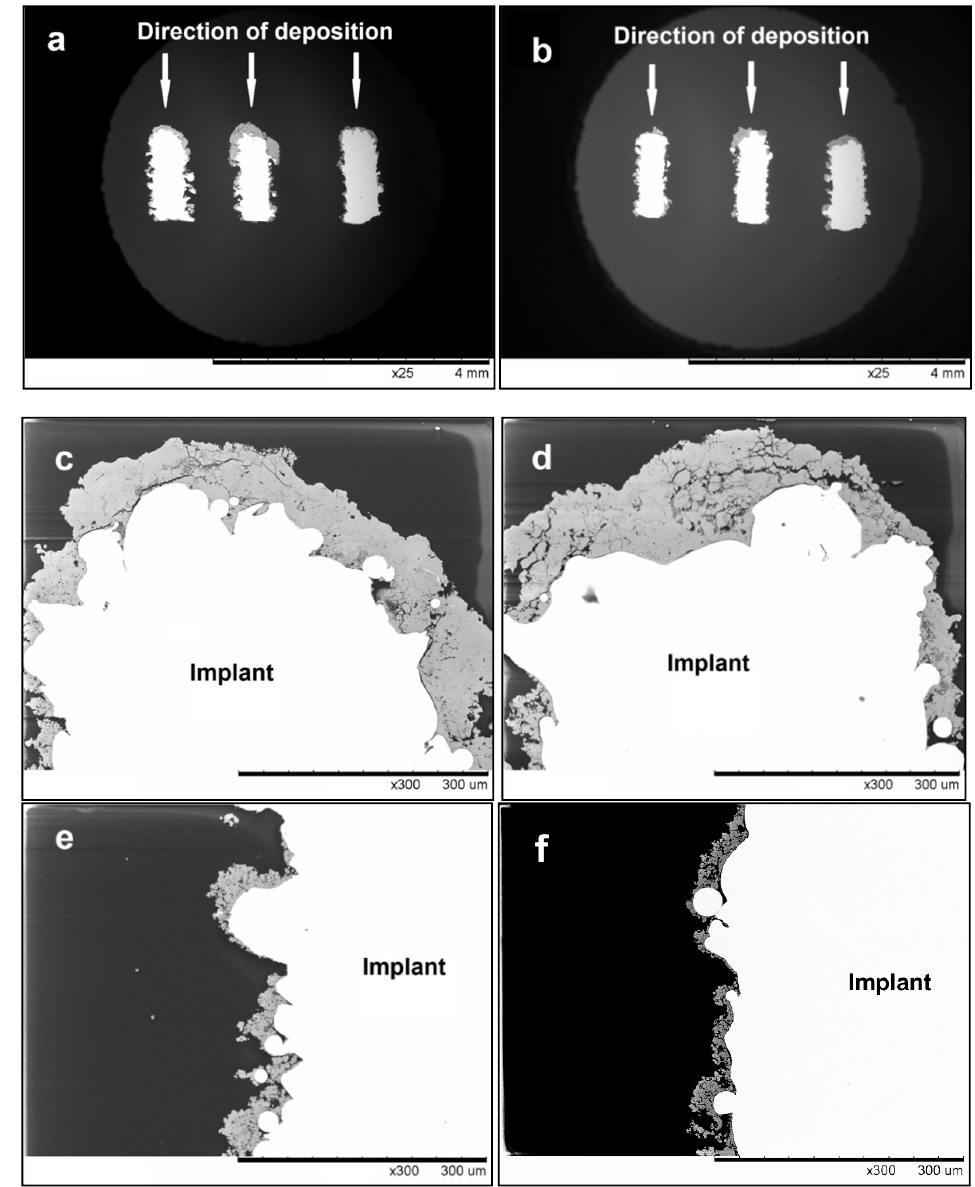
Figure 5. SEM images of the surface of the as-printed mesh plate ( a,b ) and plates coated by nano-HA ( c,d ) and calc-HA ( e,f ). General view ( a,c,e ) and surface morphology ( b,d,f ).